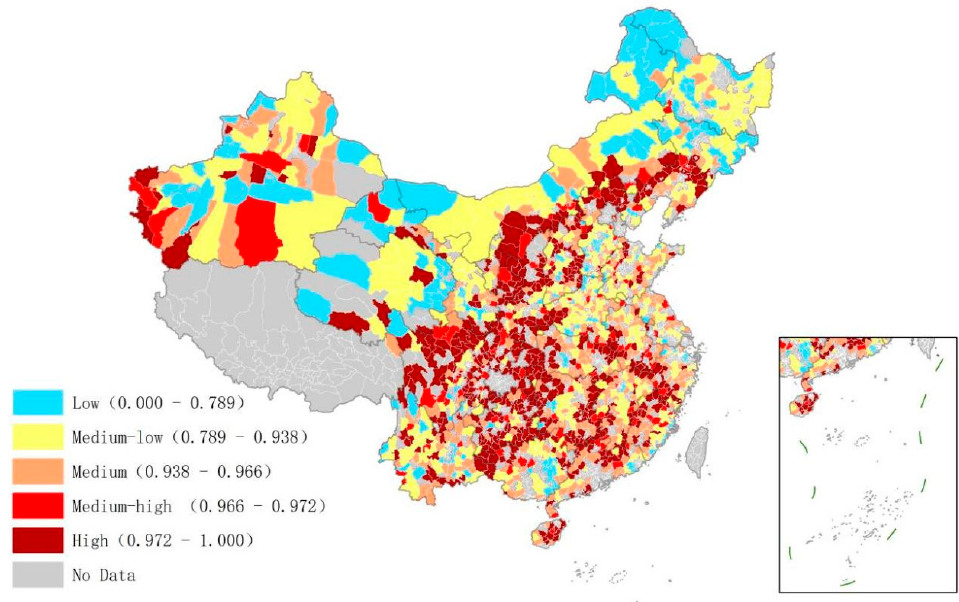
Figure 6. Low-carbon management potential of the transportation sector in Chinese counties.